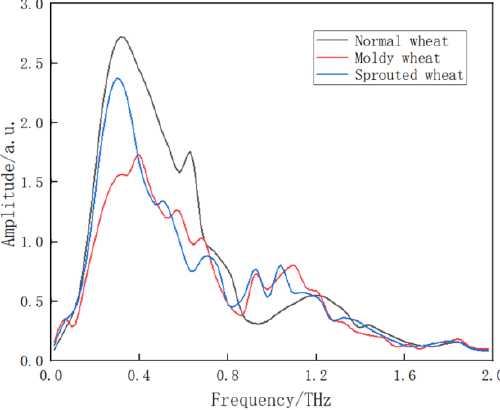
Figure 5. The THz spectrum of the sample.